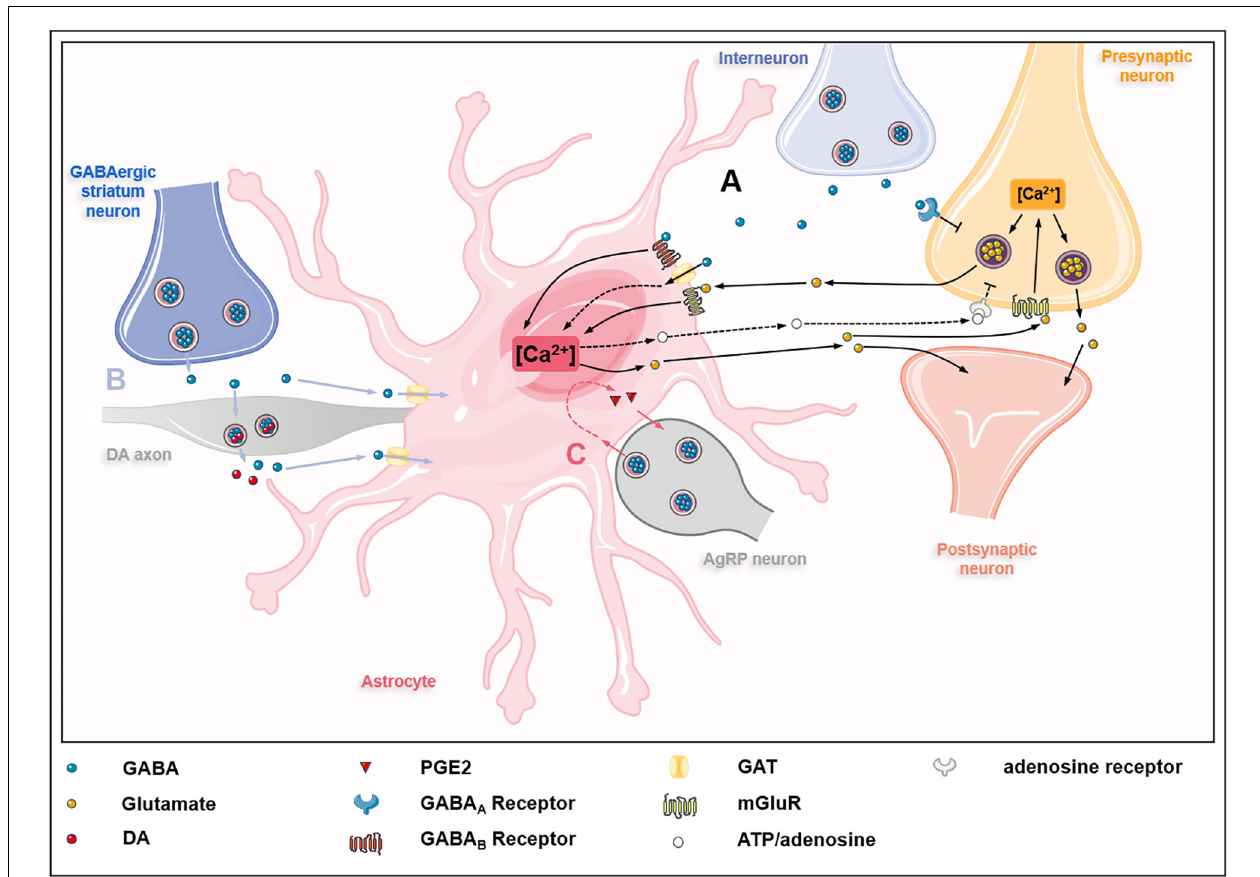
FIGURE 2 | GABAceptive astrocytes fine-tune astrocyte-neuron crosstalk. (A) GABA released by interneurons on one hand inhibits glutamate release from presynaptic neurons by acting on GABA A receptors (GABA A Rs) on presynaptic neurons; on the other hand, GABA acts on GABA B receptors (GABA B Rs), metabotropic glutamate receptors (mGluRs), and GABA transporter proteins (GATs) on astrocytes, causing Ca 2+ oscillations in astrocytes. Ca 2+ oscillations regulate the release of glutamate and ATP/adenosine. Glutamate derived from astrocytes acts on mGluRs on presynaptic neurons, thus promoting the release of glutamate from presynaptic neurons into the synaptic cleft. In addition, astrocyte-derived glutamate also acts directly on postsynaptic neurons to partially counteract the inhibitory effect of GABA. Besides, astrocyte-derived ATP/adenosine inhibits glutamate release from presynaptic neurons by activating presynaptic adenosine receptors (dashed lines). (B) GABA released by GABAergic striatum neurons acts on dopamine (DA) axons and inhibits the co-release of GABA and dopamine, which is modulated by GATs on astrocytes (blue lines). (C) GABA released by agouti-related protein (AgRP) neurons acts on astrocytes, causing astrocytes to release prostaglandin E 2 (PGE2) to activate AgRP neurons (red